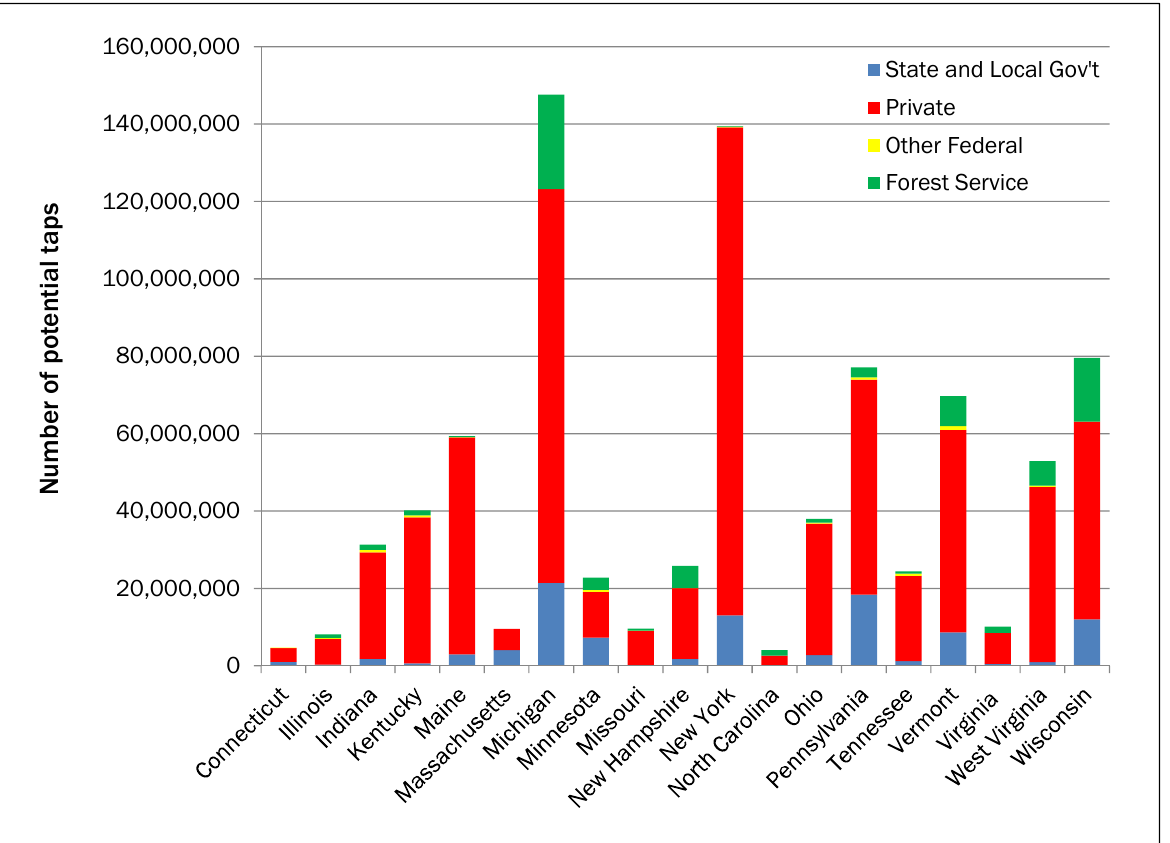
Figure 3. Number of Potential Sugar Maple Taps for 19 States by Ownership Status, 2011